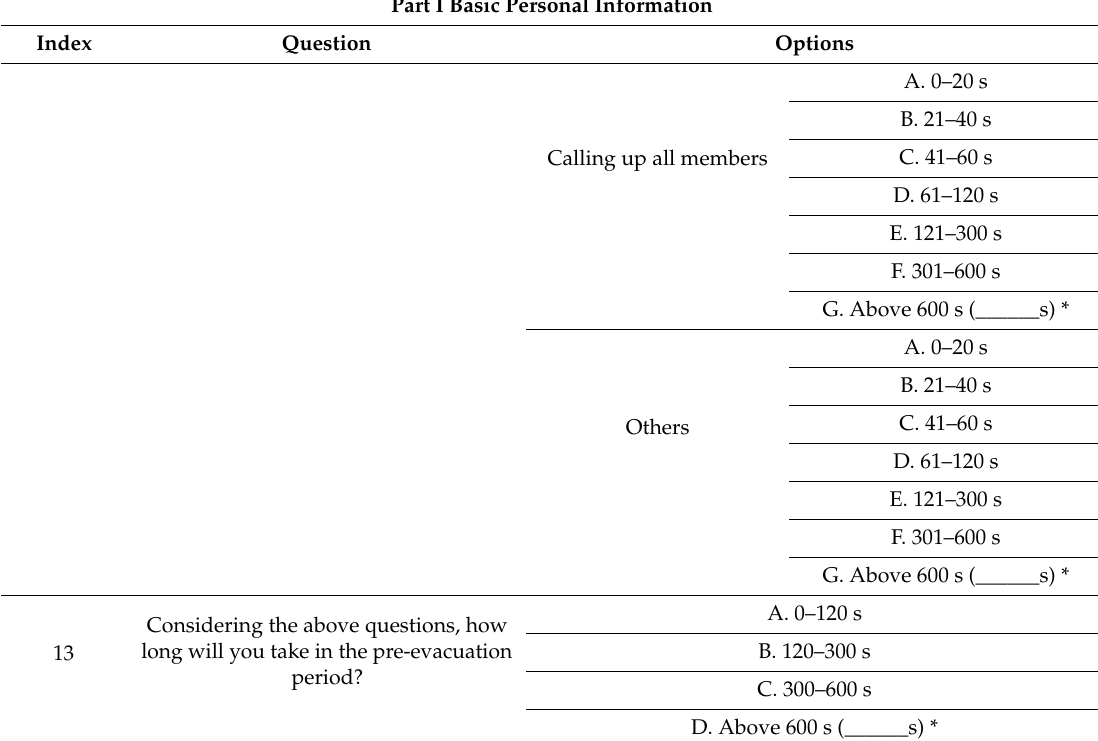
Table A1. Cont. Part I Basic Personal